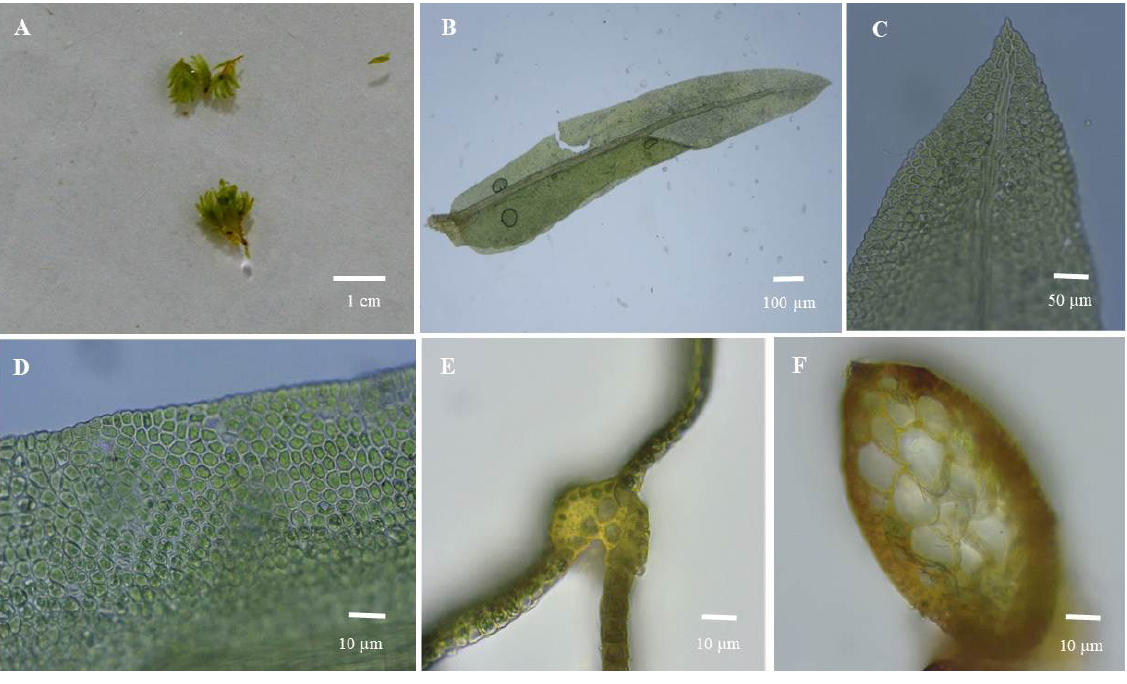
Figure 3: Fissidens crassinervis var. laxus A) Habit of the plant B) Leaf C) Bluntly acute leaf apex, D-Leaf lamina cells, E) Leaf cross section F) Cross section of